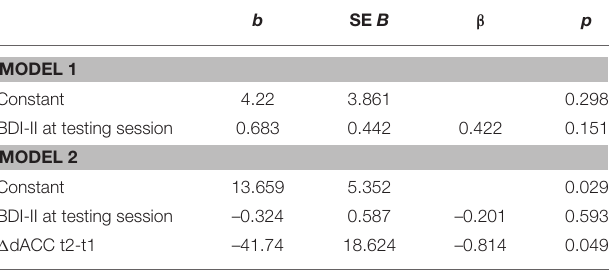
TABLE 3 | Hierarchical regression reveals significant and unique contribution of increase in activity in dorsal anterior cingulate cortex (dACC) to depression levels at 6 months following the social evaluative session in the previously depressed